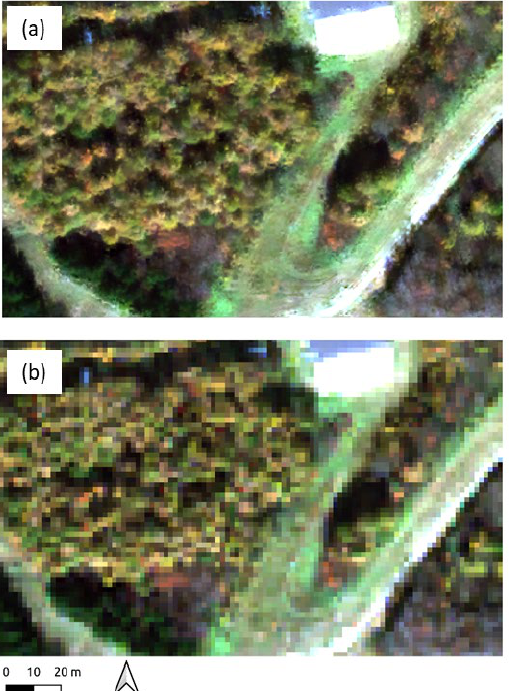
Figure 6. True color composite (Red: Band 5, Green: Band 3, Blue: Band 2) of a pan-sharpened image ( a ) and a multi-spectral image ( b ).